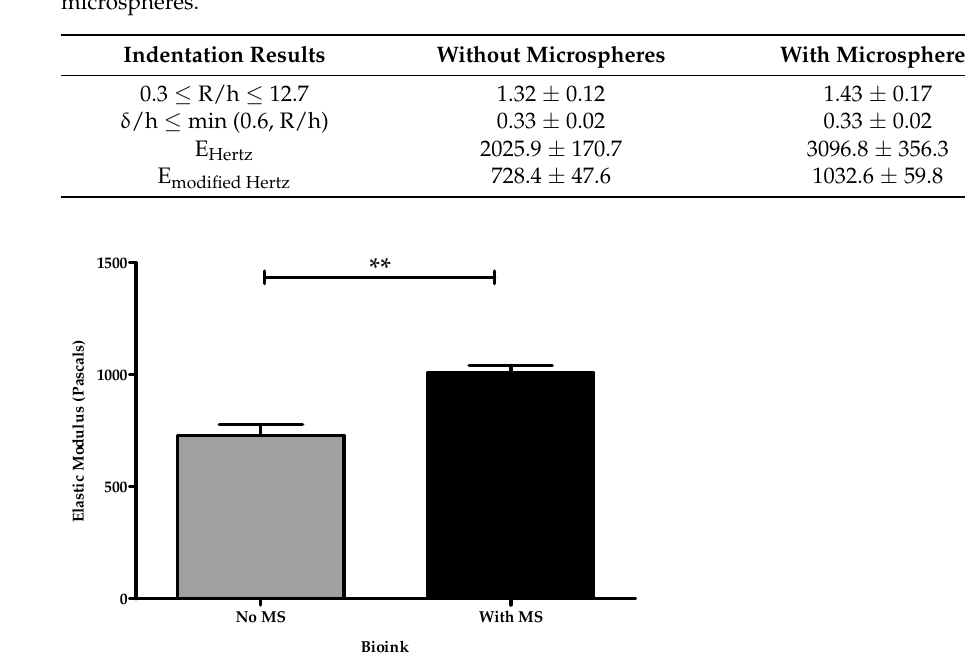
Figure 5. Elastic moduli values obtained from modified Hertz model for thin films. Data are presented as the average and standard deviation of three sample replicates. (MS: Microspheres). ** indicates that the elastic modulus are statistically different. p < 0.05. Table 1. Indentation parameters and elastic moduli values obtained for bioink with and without microspheres. Indentation Results